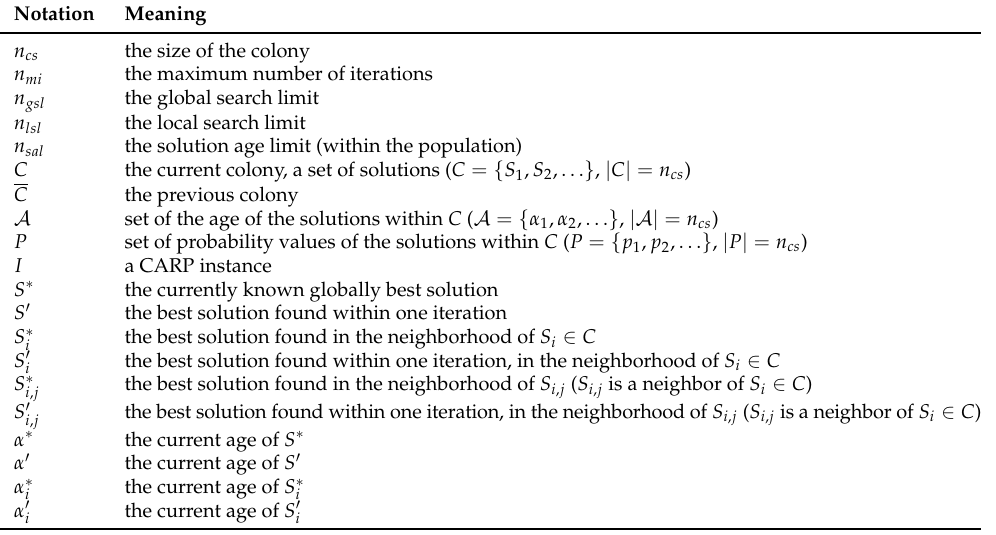
Table A2. Notations used in the CARP-ABC